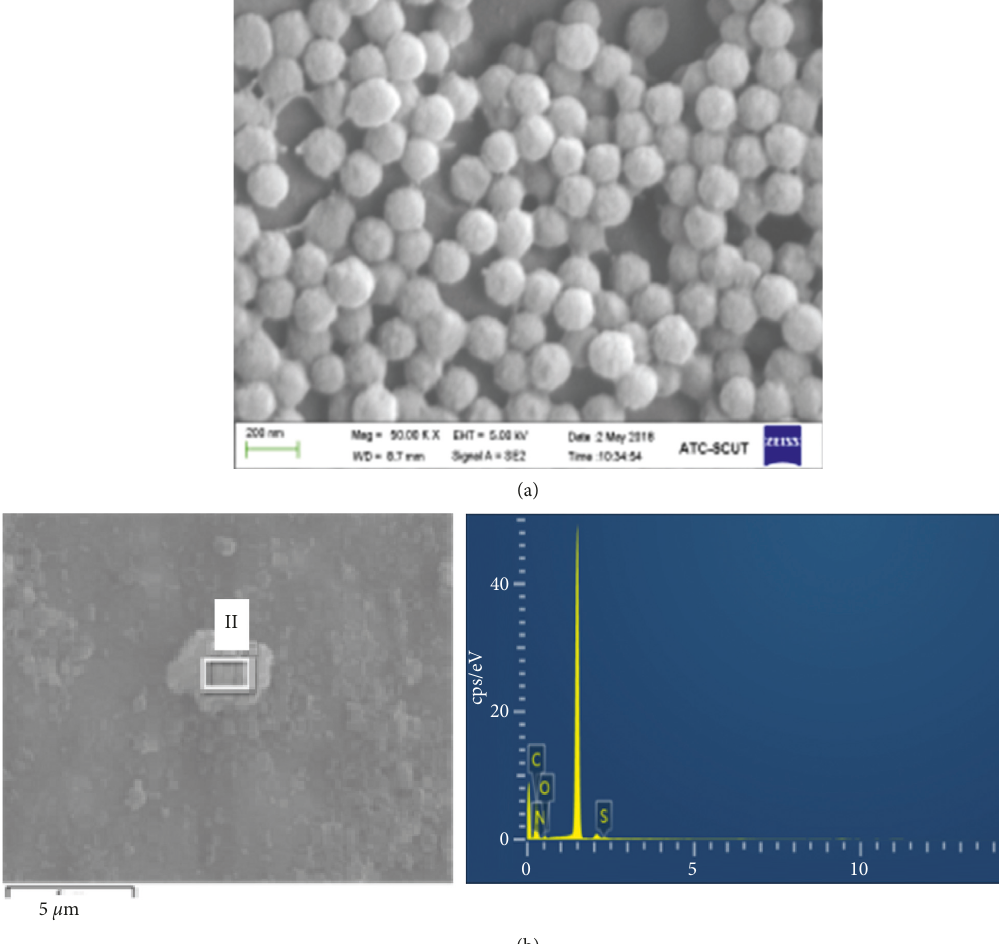
Figure 11: (a) SEM diagram of SPS nanoparticles after immobilization. (b) EDS spectrogram of SPS nanoparticles after immobilization. Table 5: Energy spectrum elements of sulfonated polystyrene nanospheres before and after immobilization. Element (before immobilization) wt.% at.% Element (after immobilization) wt.% at.% 95.24